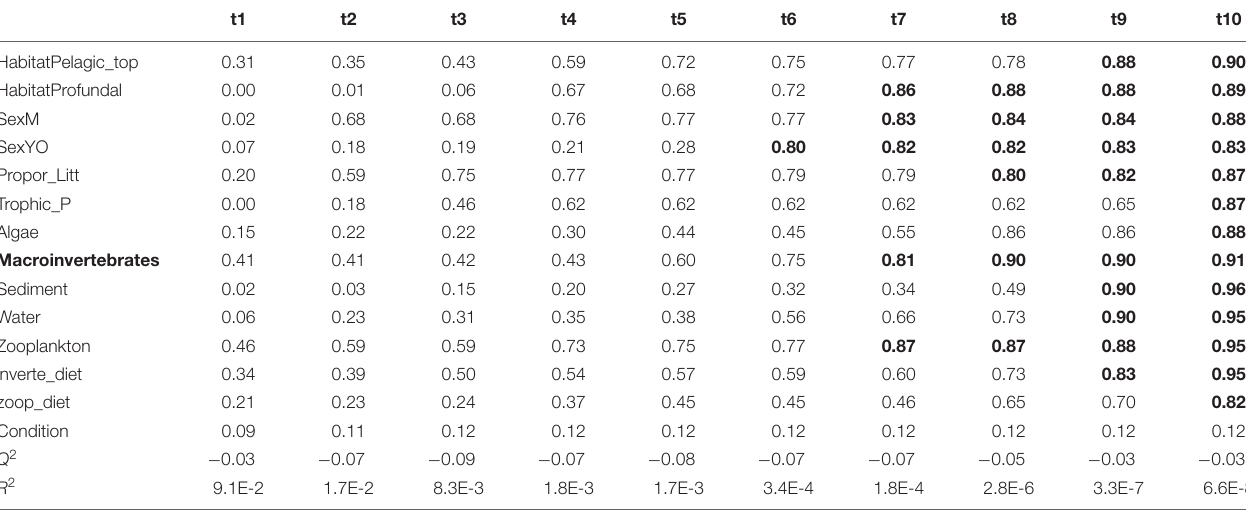
TABLE 4 | Results from PLS model 2 tested relationship between roach body condition with both environmental and dispersal factors.